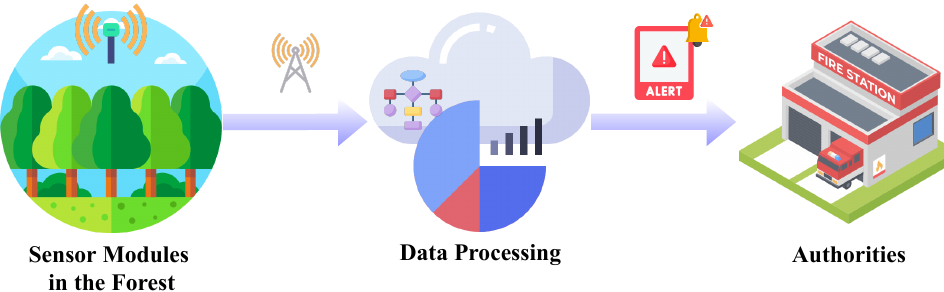
Figure 1. High-level architectural view of SAFe